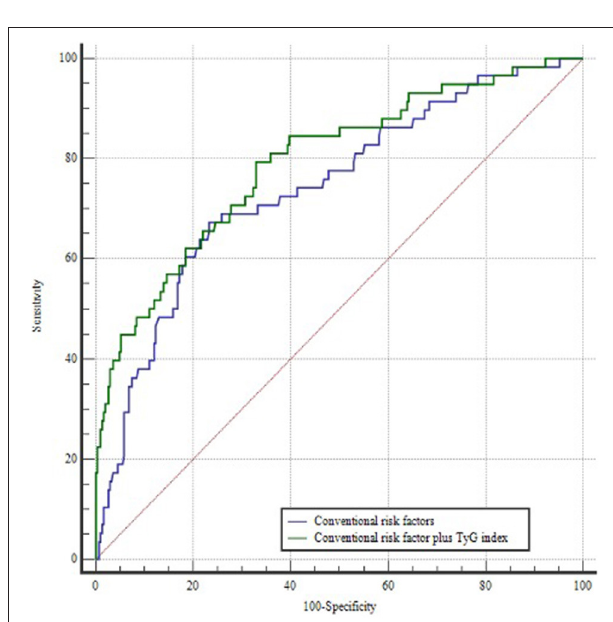
FIGURE 2 | ROC curves of the conventional risk factor model and the conventional risk factor plus TyG index model. The conventional risk factor model includes age, hypertension, and left atrial